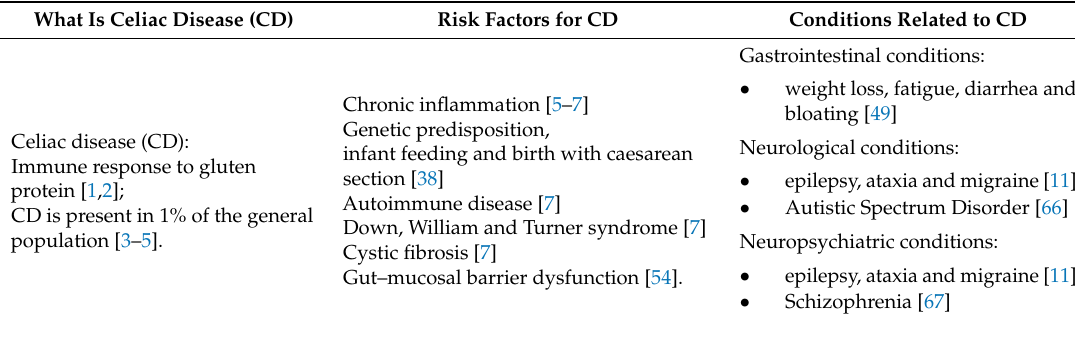
Table 1. Celiac Disease: risk factors and related